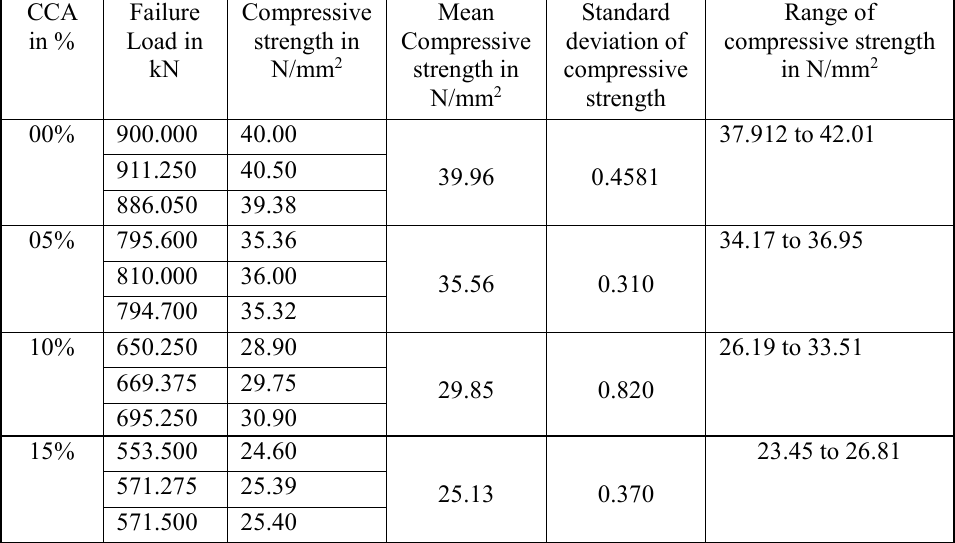
Fig. 3. Compressive strength of CCA embedded Concrete cubes at different ages of curing. Compressive strength of 56 days using Chebyshev’s